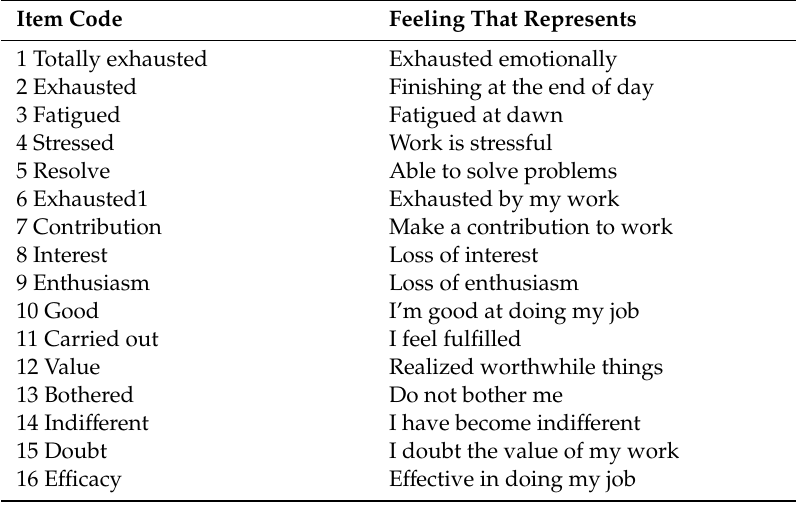
Table 1. Codes of the MBI-GS (Maslach Burnout Inventory-General Survey)